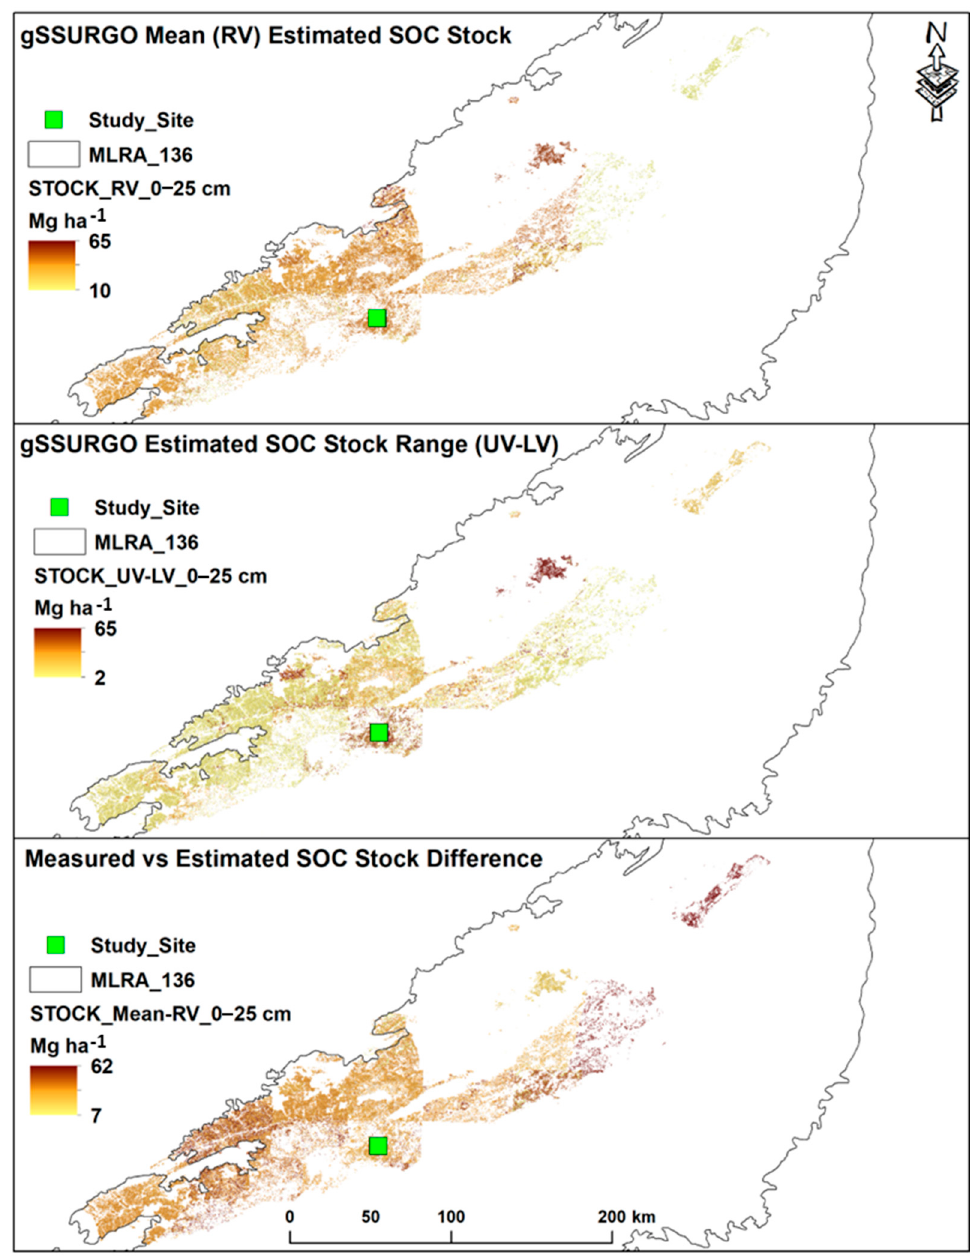
Figure 7. SOC stock distribution for the extent of the Fairview series in the study area for 0–25 cm soil thickness. The SOC stock was calculated as a mean based on the gSSURGO estimated representative value (RV) ( upper panel) as the difference between the estimated upper values (UV) and the lower values (LV) ( middle panel). The lower panel shows the difference between the measured and estimated SOC stock values.